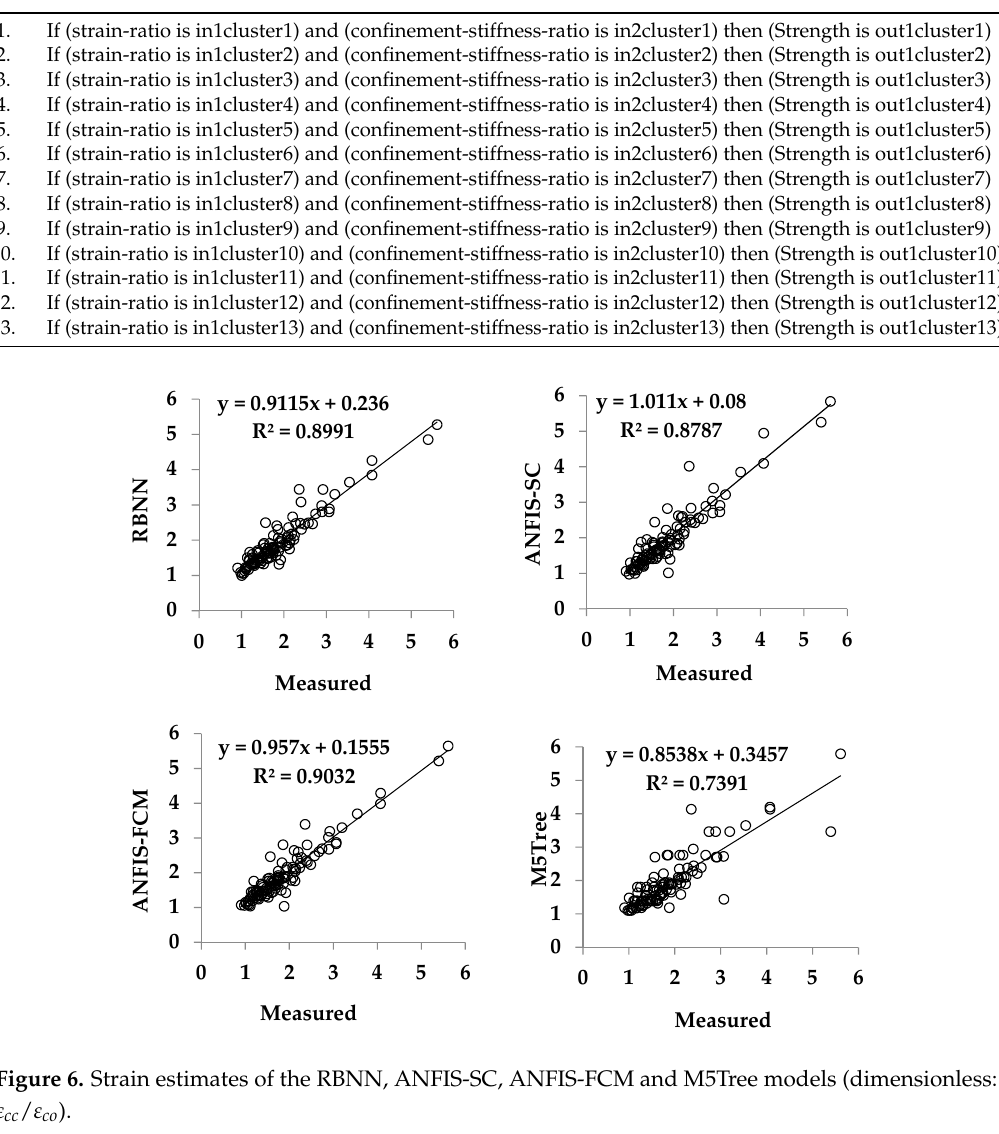
Table 5. Rule base of the optimal ANFIS-SC in modeling strain. Table 3. Rule base of the optimal ANFIS-FCM in modeling strength.